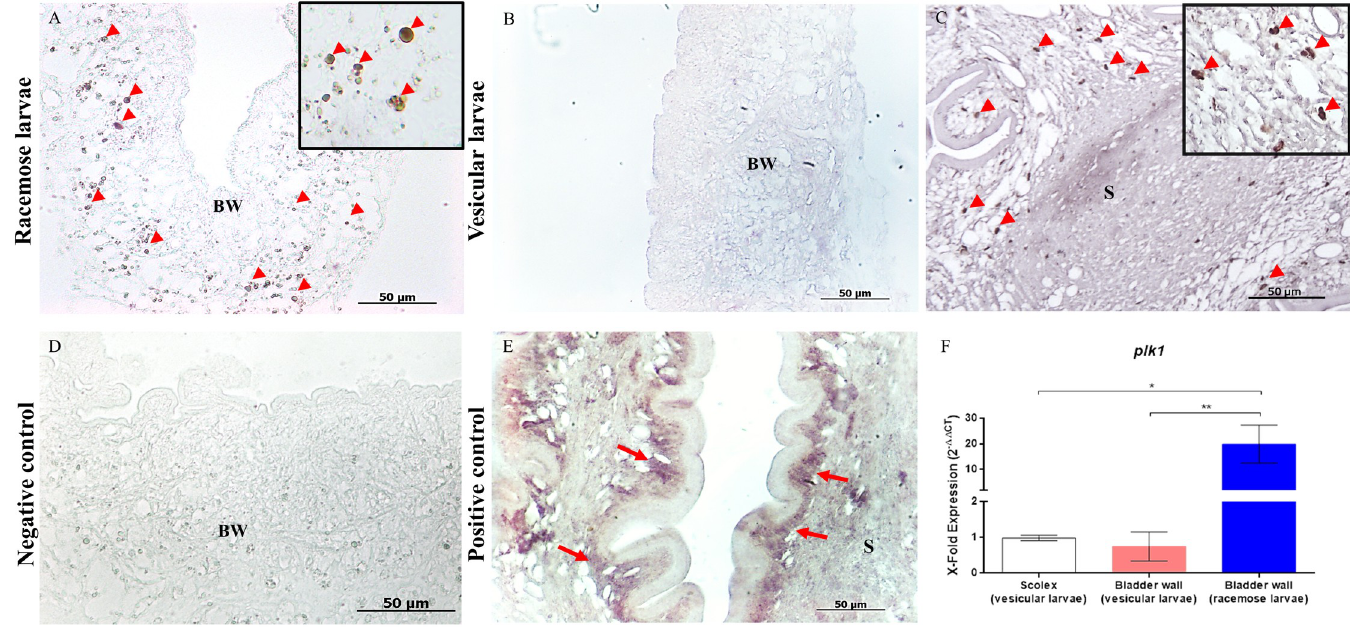
Fig 3. In situ identification of proliferative cells in Taenia solium cyst samples by ISH. Plk1 -expressing cells were observed in racemose larvae (A) and were limited to the neck of scolex in vesicular larvae (C) (arrowheads). Proliferative cell were absent in the bladder wall of vesicular larvae samples (B). A higher magnification image is inserted (A,C). A sense probe of plk1 (D) was used as a negative control and antisense probe for actin as a positive control (E) in vesicular larvae where strong staining of muscle fibers was observed (arrows). Differential expression of plk1 gene in racemose form (F). Quantitative PCR of cDNA from 500 ng of total RNA from racemose form compared to the scolex and bladder wall of vesicular form. Results are normalized to the housekeeping gapdh gene and expressed as fold increase in plk1 expression. Statistically significant differences in levels of gene expression are indicated by asterisks (Mann-Whitney U test). Asterisks represent level of significance: � : p < 0.05; �� : p < 0.01. BW: Bladder wall; S: